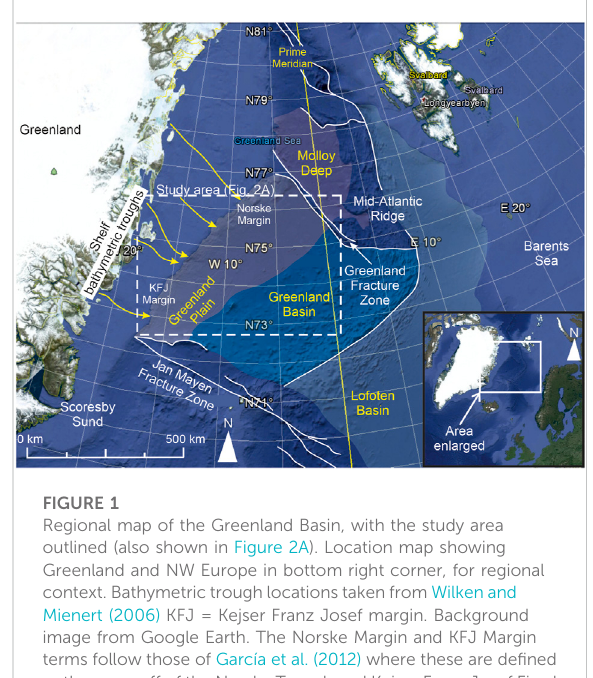
FIGURE 1 Regional map of the Greenland Basin, with the study area outlined (also shown in Figure 2A). Location map showing Greenland and NW Europe in bottom right corner, for regional context. Bathymetrictrough locations taken from Wilken and Mienert (2006) KFJ = Kejser Franz Josef margin. Background image from Google Earth. The Norske Margin and KFJ Margin terms follow those of García et al. (2012) where these are de fi ned as the areas off of the Norske Trough and Kejser Franz Josef Fjord respectively. Thus these terms refer to the northern and southern ends of the study area, and are local to these areas; therefore the geographic boundary between these two areas is unde fi ned (García et al.,